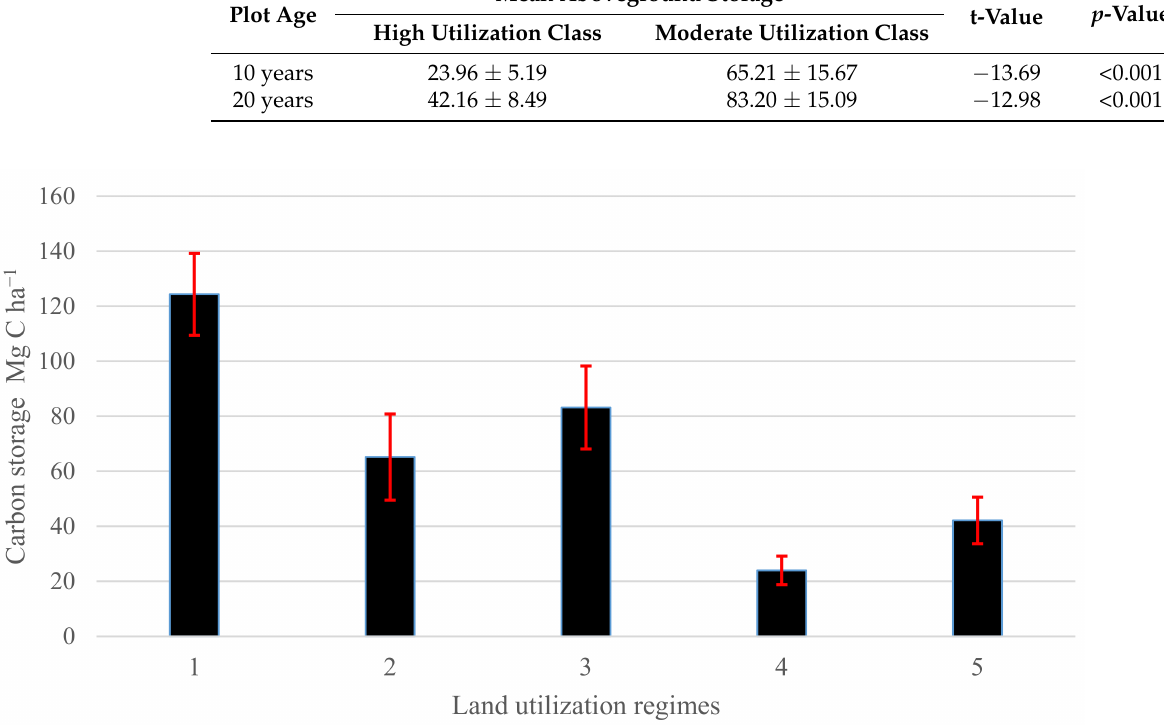
Figure 10. The effect of fallow time on carbon storage recovery. 1: Low utilization, 2: moderate utilization at 10 years of abandonment, 3: moderate utilization at 20 years of abandonment, 4: high utilization at 10 years of abandonment, 5: high utilization at 20 years of abandonment. The black box and the red line represent the mean carbon value and the standard error,